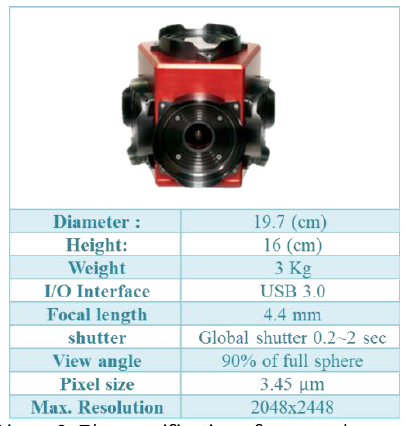
Figure 8: The specification of proposed camera